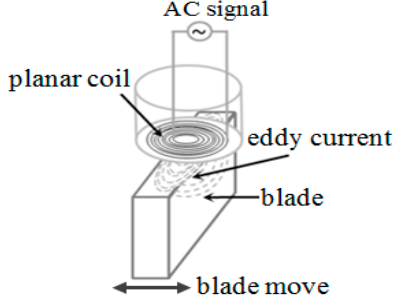
Figure 1. Schematic diagram of measuring principle.